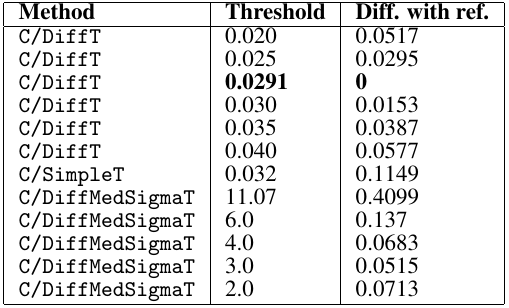
Table 3. Changes observed when estimating R agg with different thresholds and methods. Diff. with ref.: mean absolute difference observed compared to reference method (in